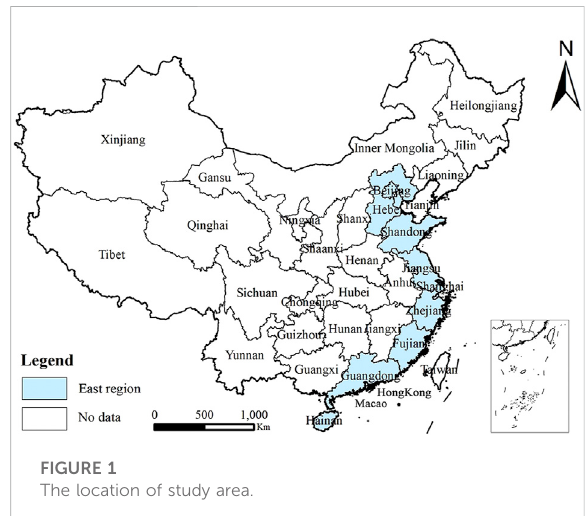
FIGURE 1 The location of study